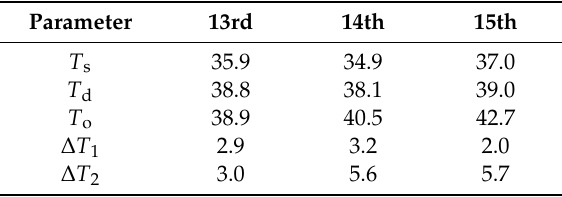
Table 7. Peak temperature comparison under Strategy 1.